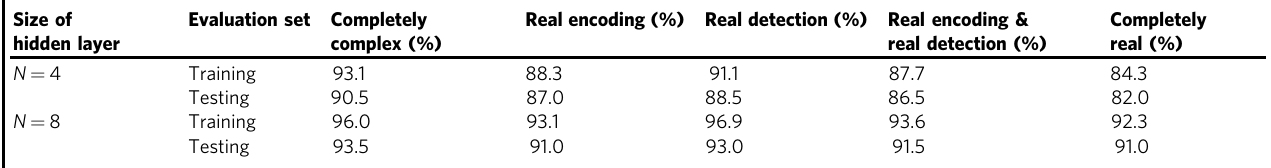
Table 1 Performance of complex-valued neural networks under different encoding and detection